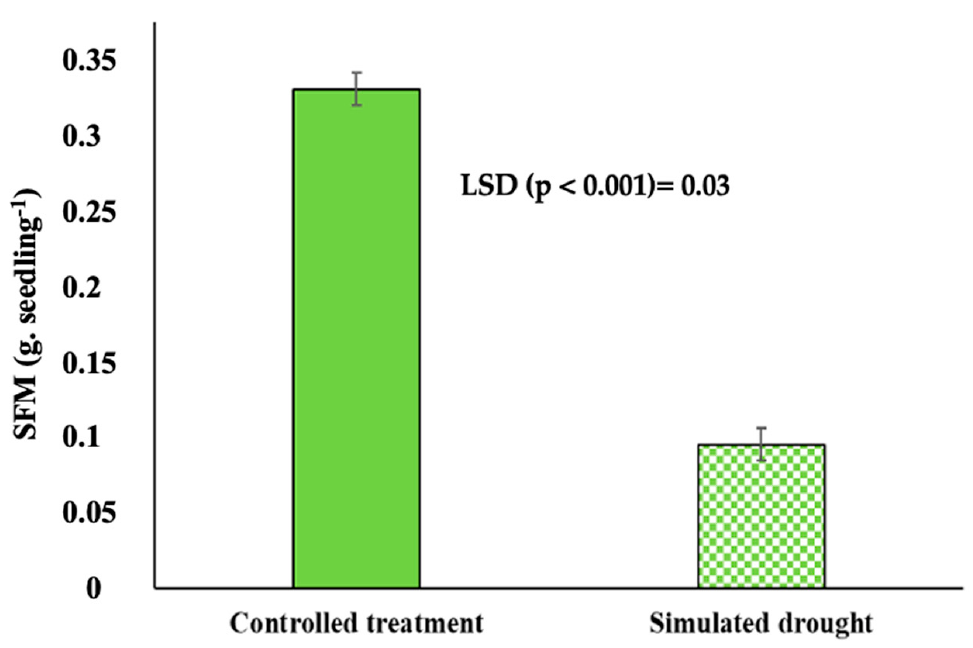
Figure 1. Seedling fresh mass (SFM) of seeds subjected to simulated drought conditions using 5% PEG compared to a control treatment using distilled water.